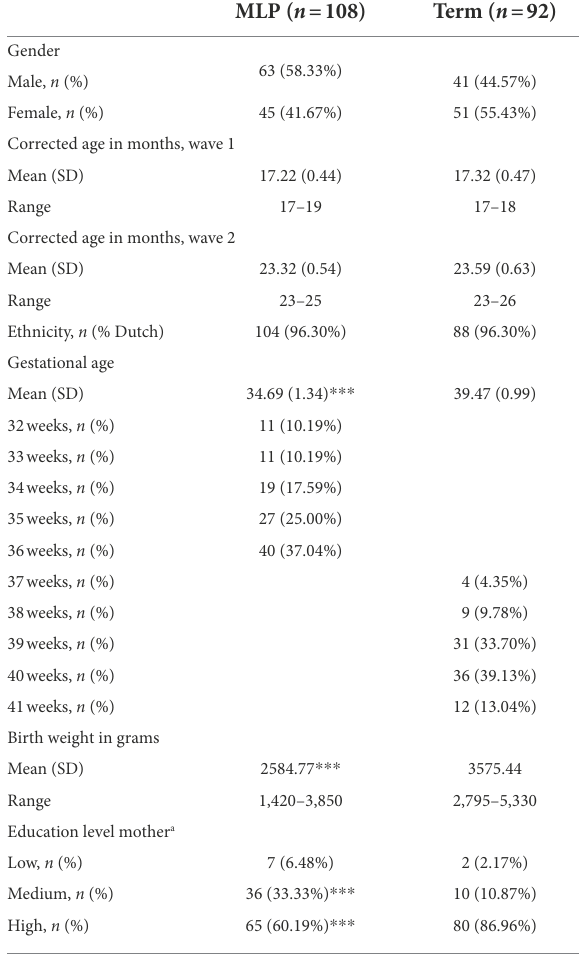
TABLE 1 Participant characteristics per group of birth